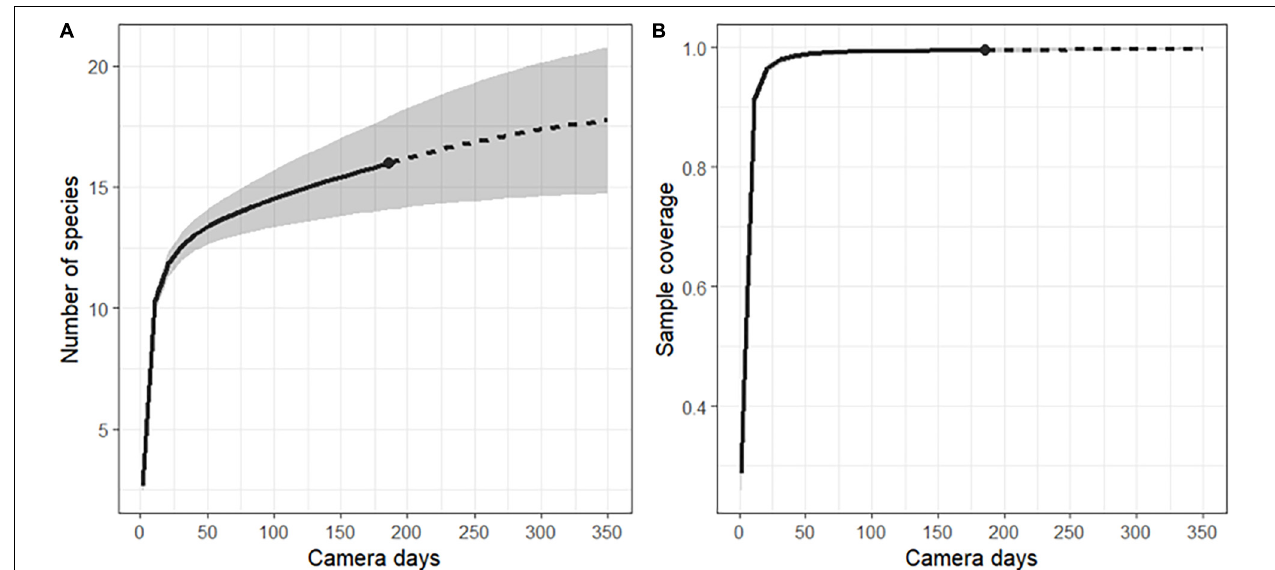
FIGURE 3 | (A) Randomized species accumulation curve and (B) coverage-based sampling curve for the ground and arboreal frugivore community of the entire study area (including forest patches A, B, C, and D) recorded in the vicinity of Manilkara and Virola trees. The shaded area represents the 95% confidence interval. The dot at the limit between the interpolated solid line and the extrapolated dashed line indicates the actual sampling effort of the study (186 days of record).